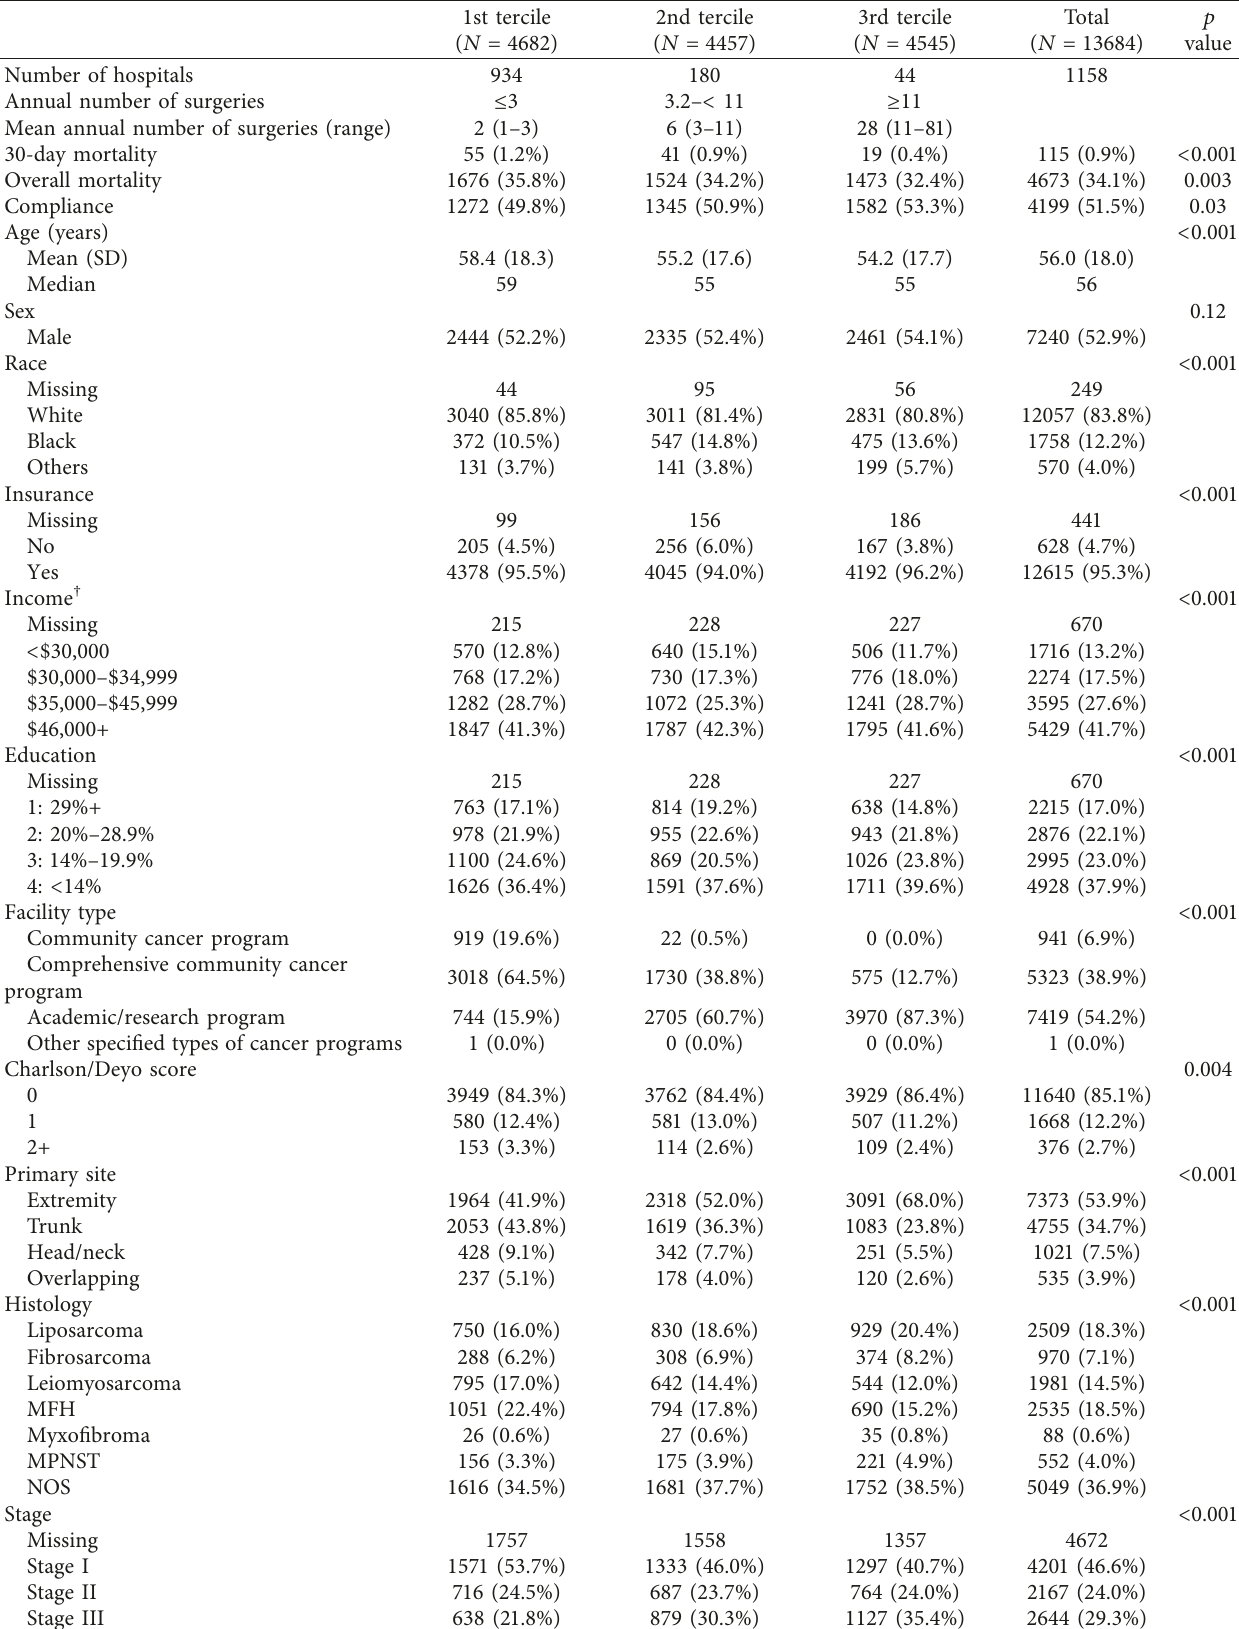
Table 2: Bivariate associations between volume tercile and patient